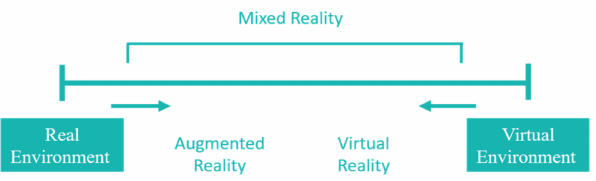
Figure 5. Reality-virtuality continuum (as presented by